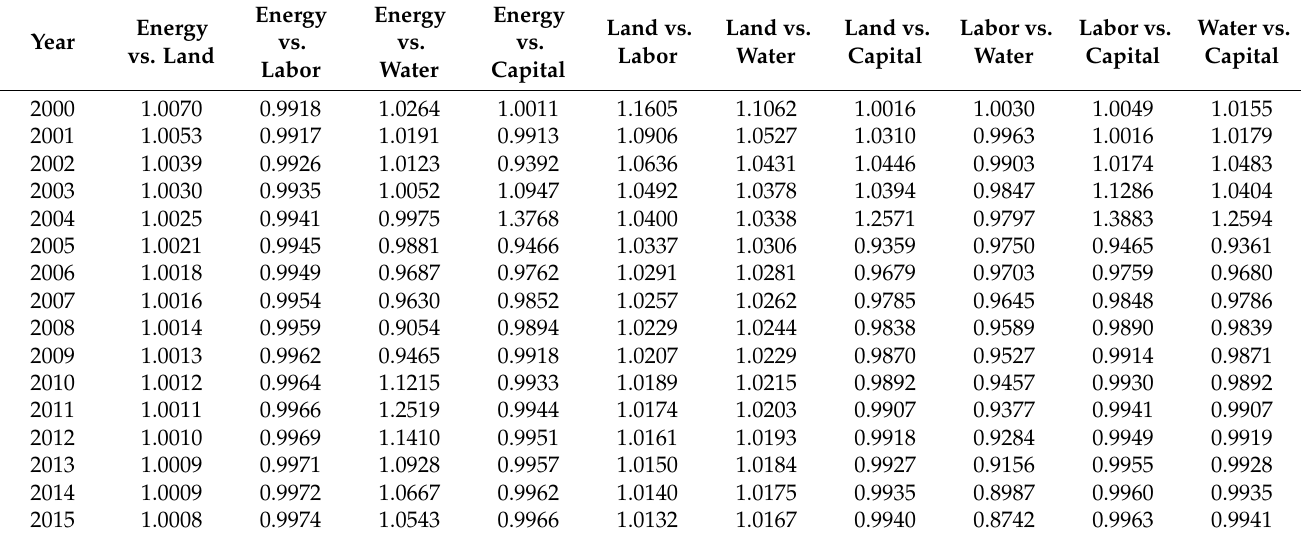
Table 6. Substitution relationship between different factors of